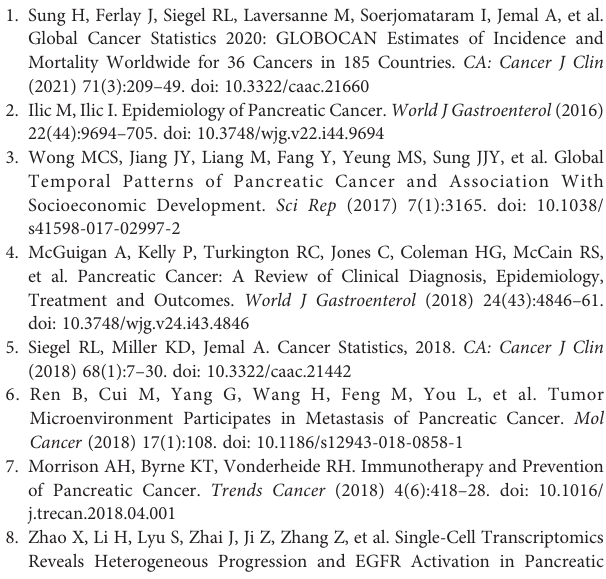
Supplementary Figure 4. | LASSO Cox regression analysis for optimizing the prognostic model. (A) The coef fi cients of each gene with the changing lambda value. Red dotted line indicates lambda = 0.0661. (B) 95% con fi dence interval of partial likelihood deviance of different lambda values. Red dot indicates lambda = 0.0661. Supplementary Figure 5. | Evaluation of the 4-gene prognostic model in GEO cohort. (A) The distribution of PAAD samples and expression of prognostic genes ranking by risk score. (B) ROC curve of the prognostic model in predicting 1-year, 3-year and 5-year overall survival. (C) Kaplan-Meier survival plot of high-risk and low-risk groups. Log-rank test was conducted. Supplementary Figure 6. | Evaluation of the 4-gene prognostic model in ICGC- AU cohort. (A) The distribution of PAAD samples and expression of prognostic genes ranking by risk score. (B) ROC curve of the prognostic model in predicting 1- year, 3-year and 5-year overall survival. (C) Kaplan-Meier survival plot of high-risk and low-risk groups. Log-rank test was conducted. Supplementary Figure 7. | Comparison of TME between high-risk and low-risk groups in GEO cohort. (A) A heatmap describing distribution of 22 immune cells in high-risk and low-risk groups. (B) Enrichment score of 10 oncogenic pathways in high-risk and low-risk groups. (C) Immune score of high-risk and low-risk groups. (D – F) Expression of immune checkpoints (D) , chemokines (E) and chemokine receptors (F) in two groups. Student t test was performed between two groups. ns, no signi fi cance. *P < 0.05, **P < 0.01, ***P < 0.001, ****P < 0.0001. Supplementary Figure 8. | (A) Association between IS1-2 and existing molecular subtypes and patients in high-risk and low-risk groups. (B) Interaction between four key genes. (C) Relationship between the expression offour key genes and memory B cells. Supplementary Figure 9. | (A) Markers of MBC_0, MBC_1 and MBC_2. (B) The distribution of three MBC subgroups in different pseudotime. (C) The distribution of seven markers in different pseudotime. Supplementary Figure 10. | (A) Prognostic difference forest map of DDK1 in Pan cancer. (B) Prognostic difference forest map of ANLN in Pan cancer. (C) Prognostic difference forest map of SERPINB5 in Pan cancer. (D) Prognostic difference forest map of ARNTL2 in Pan